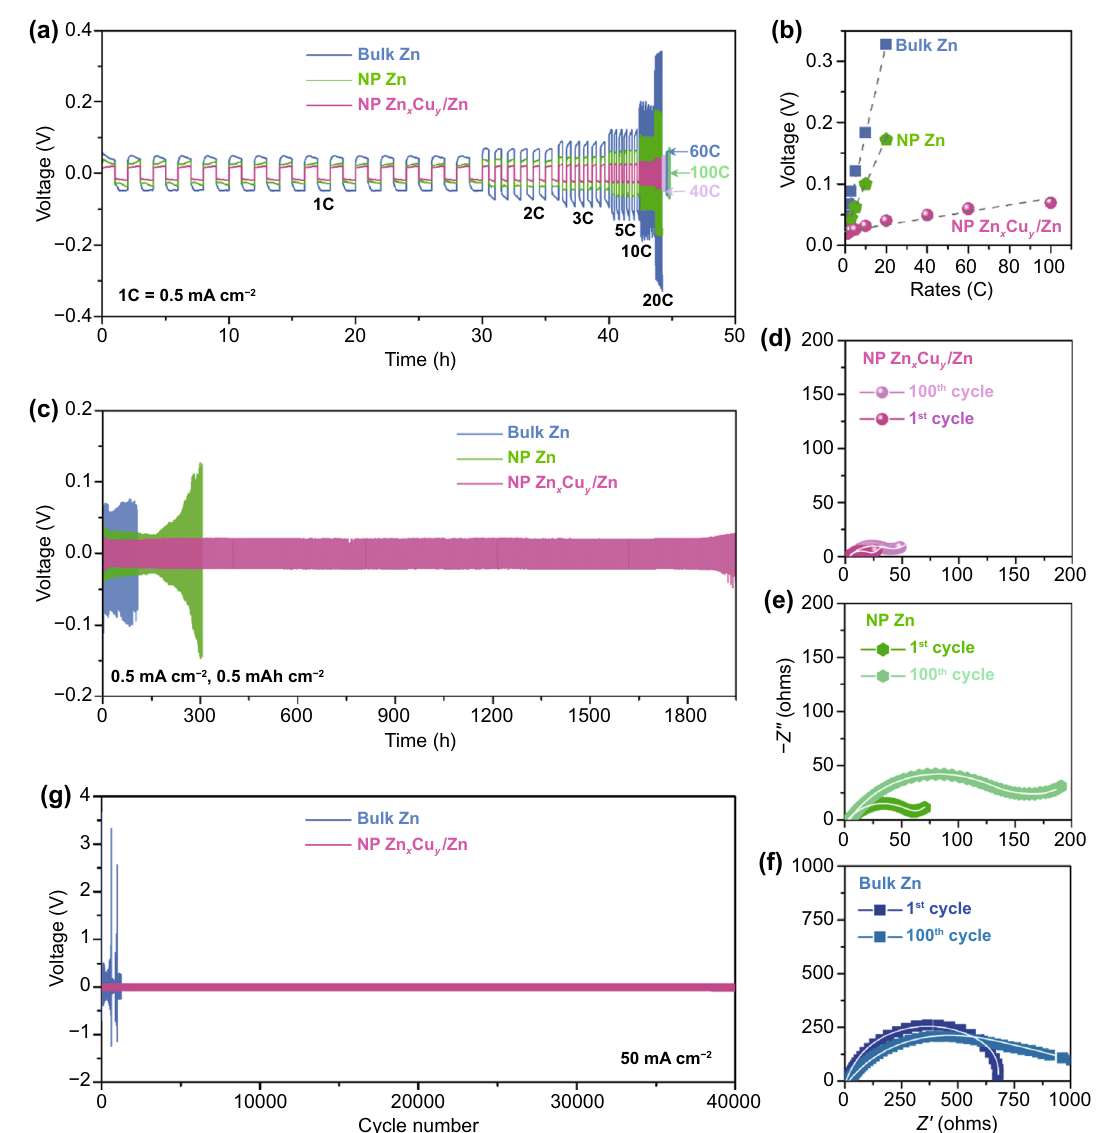
Fig. 3 Electrochemical performance of symmetric cells. a Voltage profiles of nanoporous Zn x Cu y /Zn symmetric cell at various rates from 1 to 100C (1C = 0.5 mA cm ‒ 2 ) in 1 M Zn(OTF) 2 with 1 mM SDS, comparing with those of symmetric batteries of bulk Zn and nanoporous Zn elec‑ trodes in 1 M Zn(OTF) 2 . b Overpotentials of Zn stripping/plating for symmetric cells based on nanoporous Zn x Cu y /Zn and nanoporous Zn, bulk Zn in 1 M Zn(OTF) 2 with/without 1 mM SDS as a function of rate. c Long‑term cycling stability of Zn stripping/plating for symmetric cells based on nanoporous Zn x Cu y /Zn and nanoporous Zn, bulk Zn in 1 M Zn(OTF) 2 with/without 1 mM SDS.EIS spectra of d nanoporous Zn x Cu y / Zn, e nanoporous Zn and f bulk Zn symmetric cells before and after 100 cycles of stripping/plating in 1 M Zn(OTF) 2 with/without 1 mM SDS. g Long‑term Zn stripping/plating stability of symmetric cells based on nanoporous Zn x Cu y /Zn and bulk Zn electrodes in 1 M Zn(OTF) 2 with/ without 1 mM SDS at 50 mA cm ‒ 2 ,